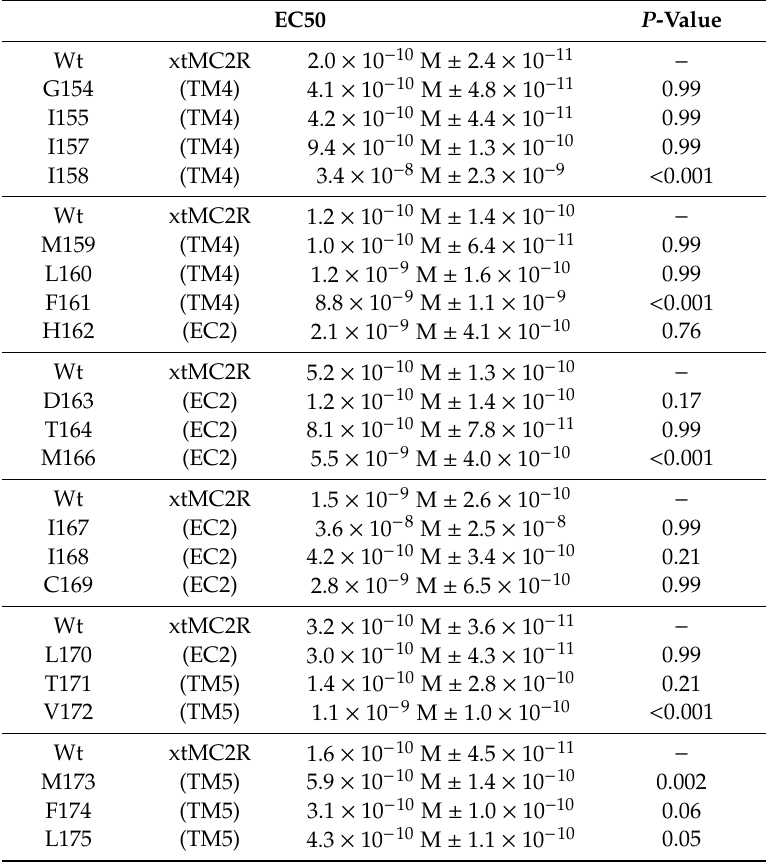
Figure 2. Dose response curves for xtMC2R, and single alanine mutants of xtMC2R. The wild-type receptor (xtMC2R) and single alanine mutants of xtMC2R were co-expressed with cMRAP in Chinese hamster ovary (CHO) cells as described in Materials and Methods. After two days in culture the transfected cells were stimulated with hACTH(1-24) at concentrations ranging from 10 − 12 M to 10 − 6 M. The data points are mean + SEM, n = 3. The data was analyzed by one-way ANOVA as described in METHODS, and EC50 values are presented in Table 1. ( A ) WT xtMC2R, G154 / .A, I155 / A, I157 / A, I158 / A. ( B ) WT xtMC2R, M159 / A, L160 / A, F161 / A, H162 / A. ( C ) WT wtMC2R, D163 / A, T164 / A, M165 / A. ( D ) WT xtMC2R, I167 / A, I168 / A, C169 / A. ( E ) WT wtMC2R, L170 / A, T171 / A, V172 / A. ( F ) XT xtMC2R, M173 / A, F174 / A, L175 / A. Table 1. EC50 Values for xtMC2R Single Alanine Mutants.